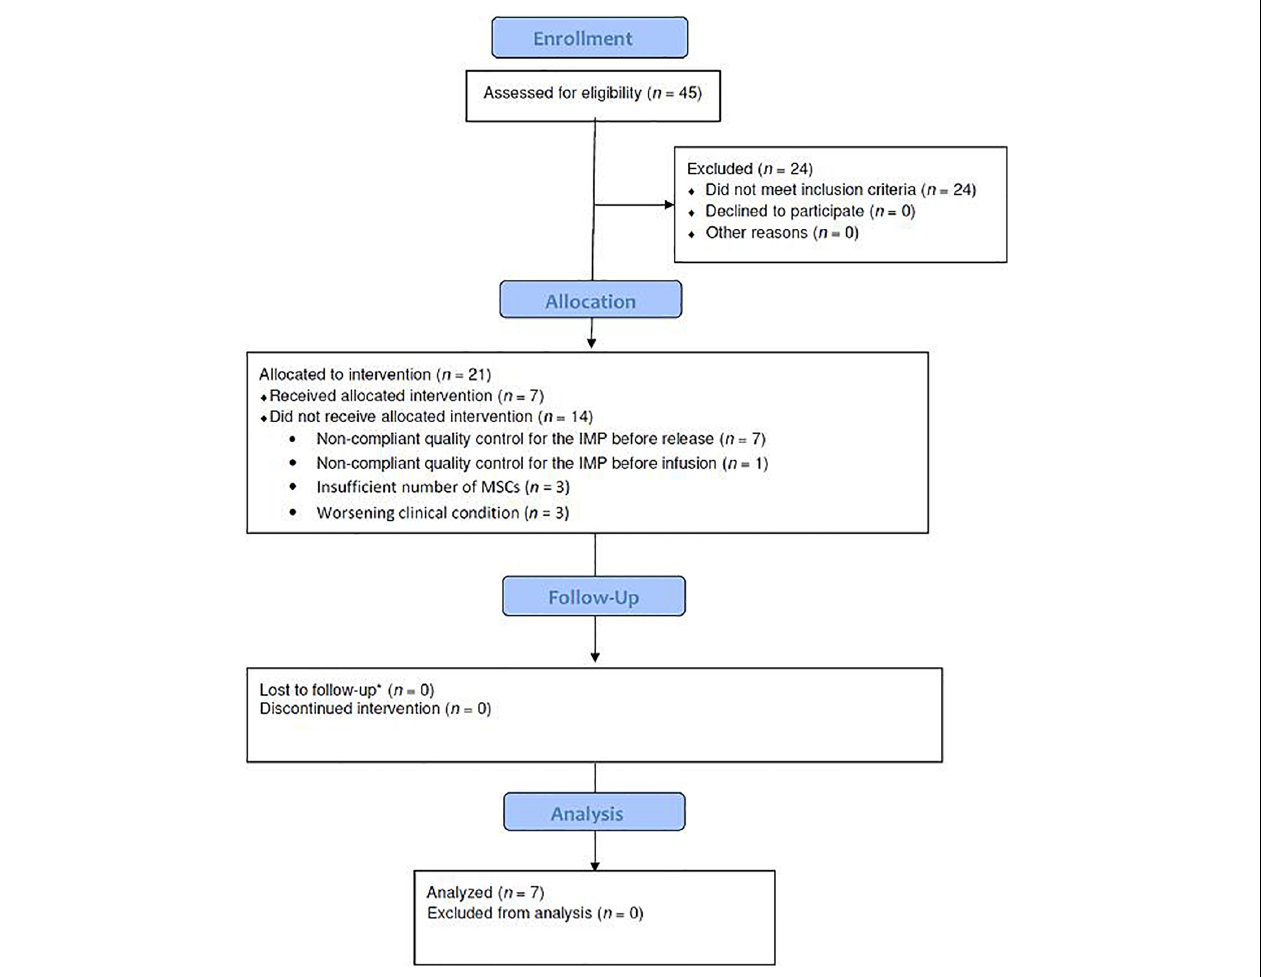
FIGURE 1 | Study flow diagram showing the patient enrollment, allocation, follow-up, and analysis in the phase I study. IMP, investigational medicinal product; MSCs, mesenchymal stromal cells.